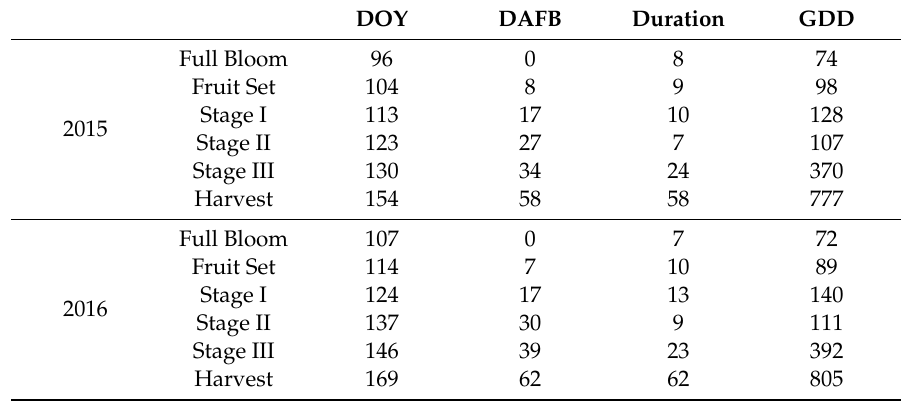
Figure 3. Seasonal fruit growth of ‘Prime Giant’/SL64 sweet cherry combination during 2016 ( A ) and 2017 ( B ) to CTL, SDI and RDI irrigation treatments and fruit growth pattern related to growing degree days (GDD) ( C ). Each observation corresponds to an average value for each treatment (n = 4). n.s. refers to not significant differences among irrigation treatments, according to ANOVA ( p < 0.05). Table 3. Lengths of sweet cherry development stages as day of the year (DOY), days after full bloom (DAFB), number of days elapsed between stages (Duration) and growing degree days base 4 °C (GDD).